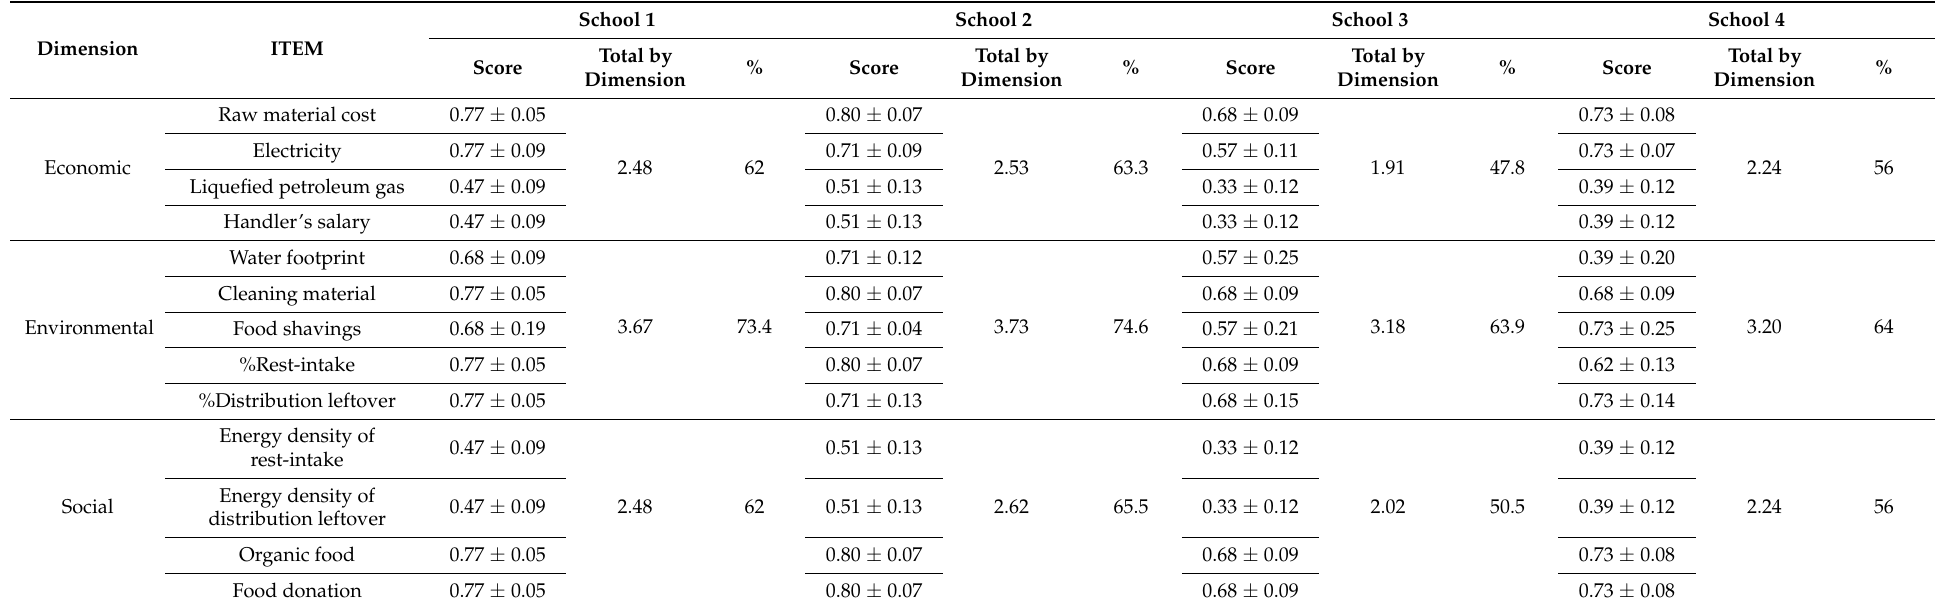
Table 2. Eco-inefficiency average, standard deviation ( ± SD), and percentage of the score (%) of the environmental, social, and economic impacts of each school’s waste in a five-day menu evaluation in the pilot